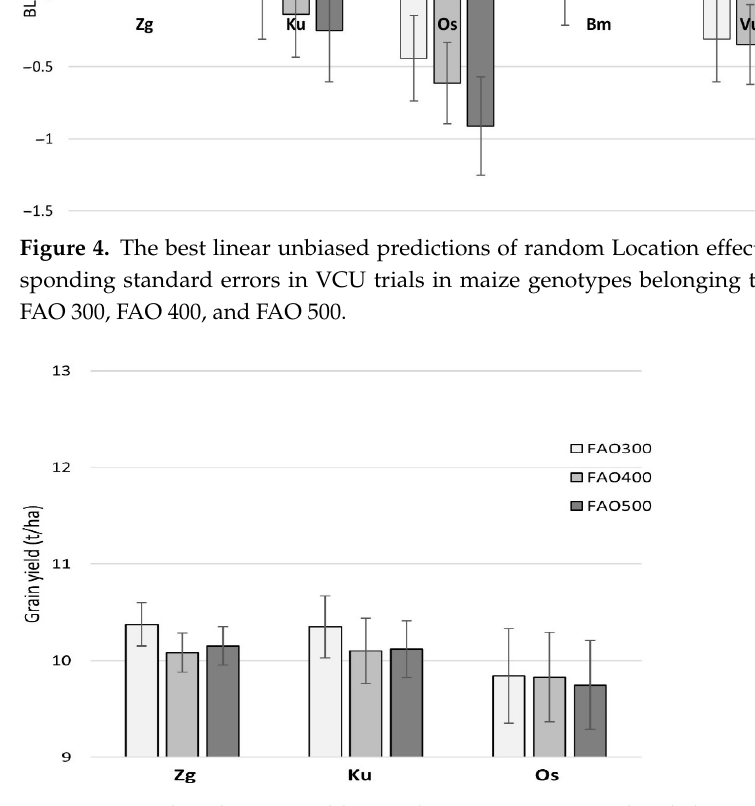
Figure 5. Predicted grain yield according to APSIM simulated data averaged over the period 2001–2019 with corresponding standard errors in maize genotypes belonging to three maturity groups FAO 300, FAO 400, and FAO 500 at three geographically distinct locations in Croatia.